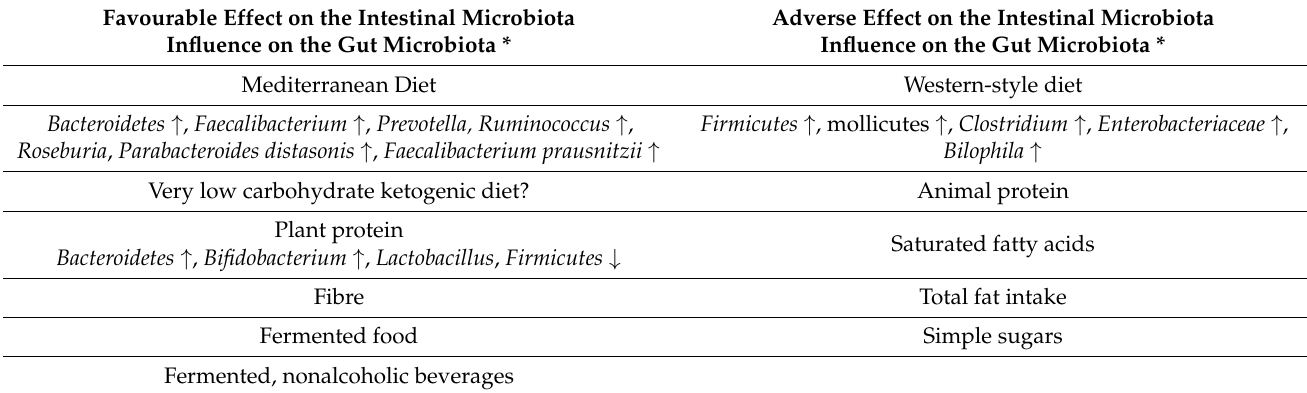
Table 3. The effect of several diets/macronutrients on the intestinal microbiota composition. Favourable Effect on the Intestinal